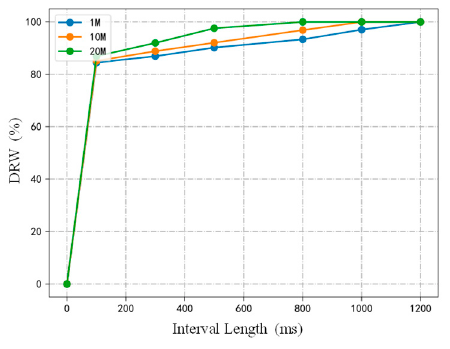
Figure 8. The DRW in different intervals and flow rates.